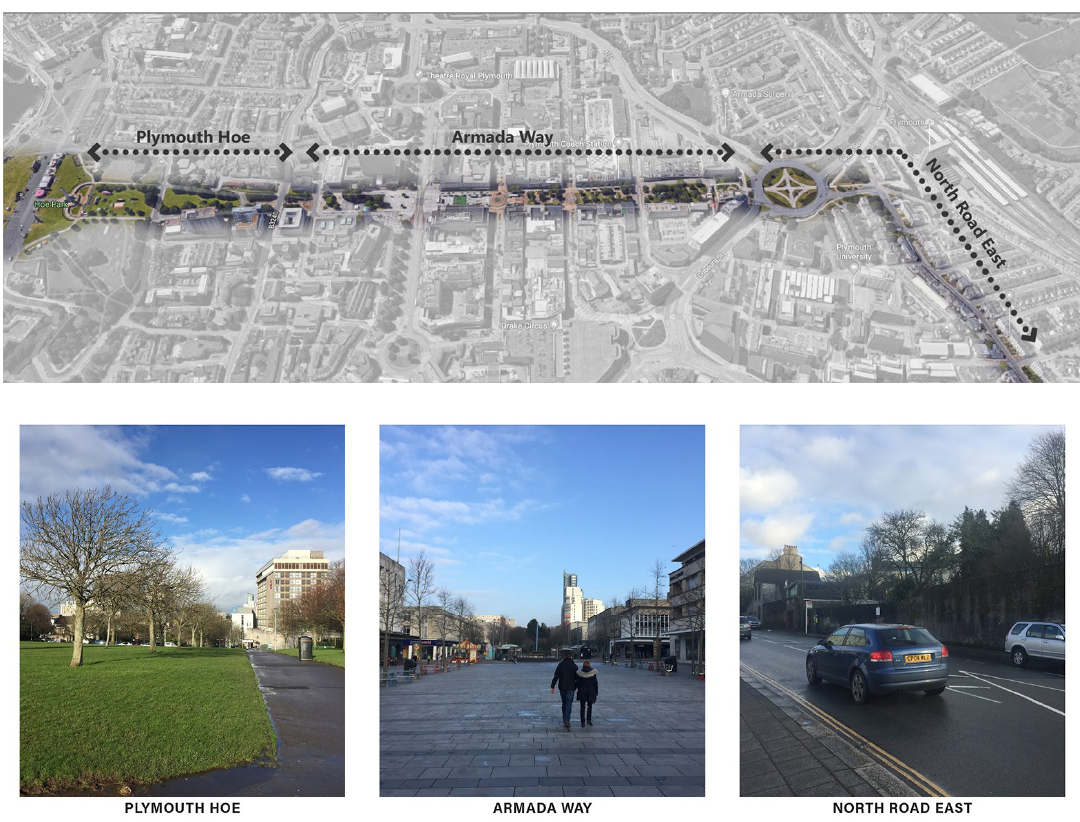
Figure 6. Study Route—Participants start walking from Plymouth Hoe, through Armada Way and ends in North Road East. Table 1. Names and types of key urban spaces along the walking route‐ ranging from green space on Plymouth Hoe to a busy road at North Read East.